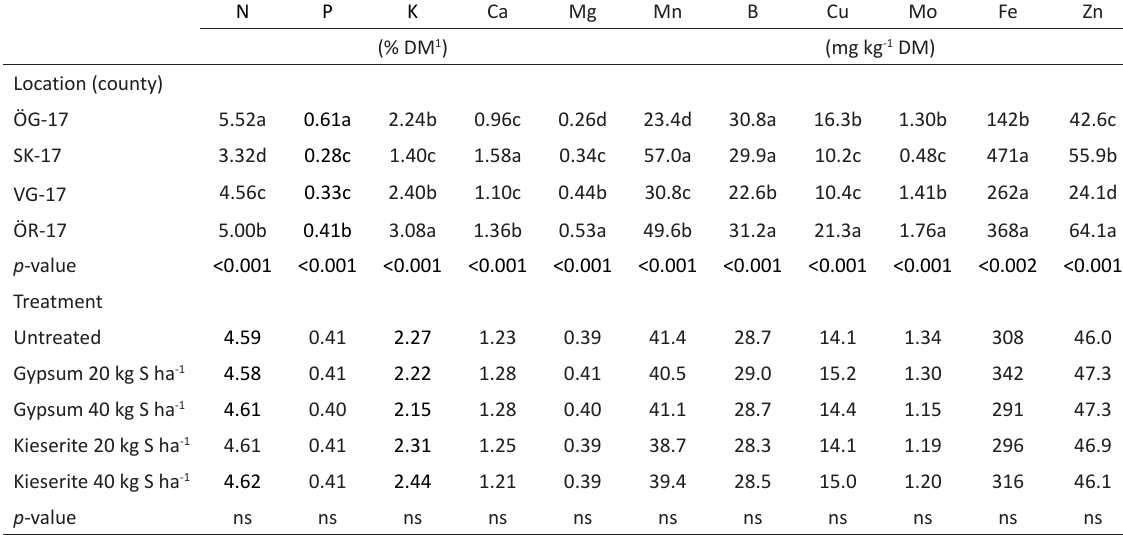
Table 4. Concentrations of macro- and micronutrients in faba bean at the beginning of flowering (BBCH 60) at the four field trial locations in 2017 with various sulphur treatments N P K Ca